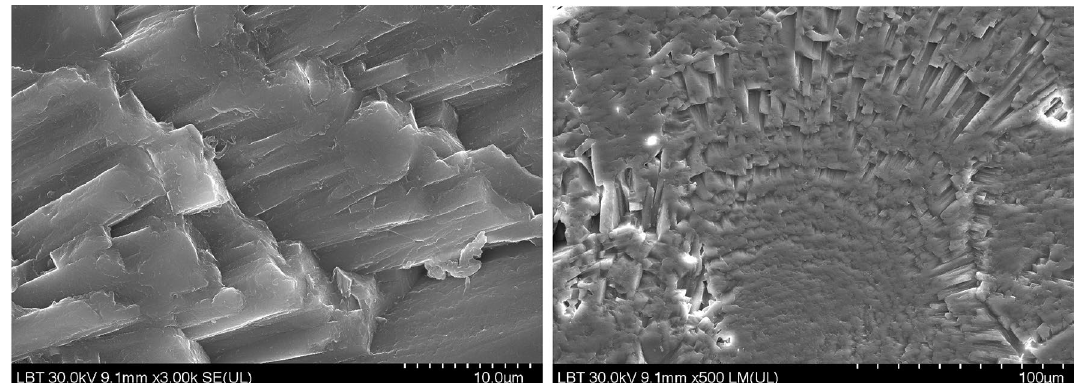
Figure 6. Scanning Electron Microscopy images of a randomly selected otolith surface with different magnifications, revealing the needle-like aragonite crystal structure (left) and the radial crystal growth (left).